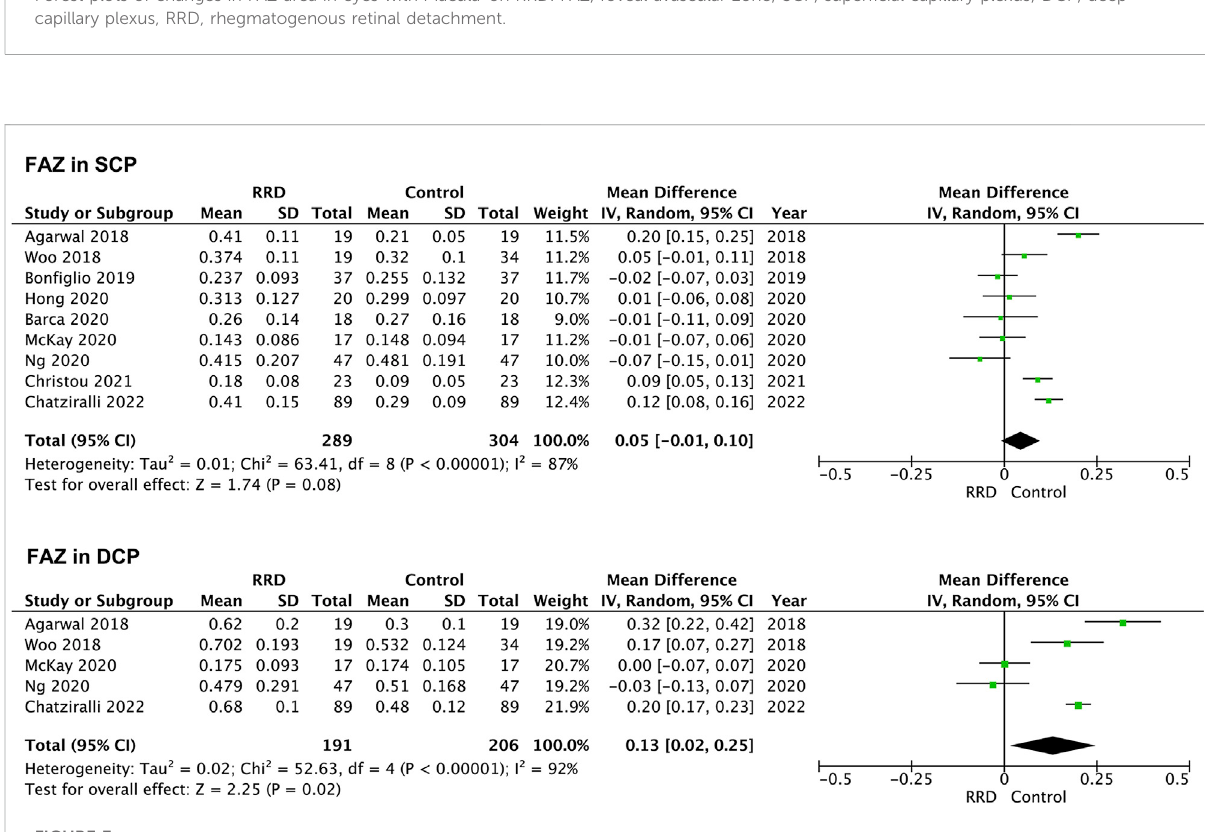
FIGURE 3 Forest plots of changes in FAZ area in eyes with Macula-off RRD. FAZ, foveal avascular zone; SCP, super fi cial capillary plexus; DCP, deep capillary plexus, RRD, rhegmatogenous retinal